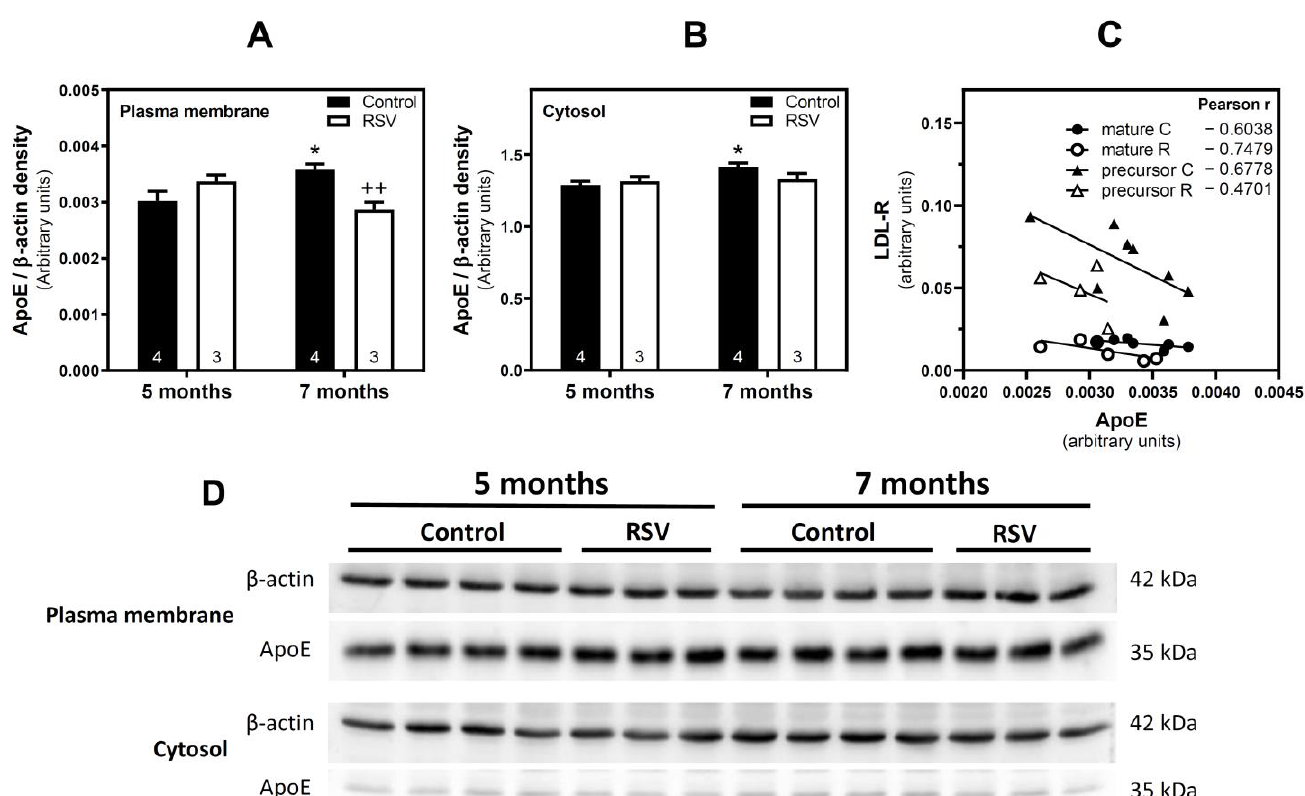
Figure 3. Analysis of ApoE in the brain of SAMP8 mice. The cholesterol carrier ApoE located in the plasma membrane ( A ) and cytosol ( B ) was analysed by Western blotting ( D ) and correlated to LDL-R levels ( C ). β -actin was used as a gel loading control. Data are the mean ± SEM of the indicated different samples. Two-way ANOVA and a Sidak test for multiple comparisons were applied. * p < 0.05: significantly different from the corresponding 5 mo value; ++ p < 0.01: significantly different from the corresponding control group.